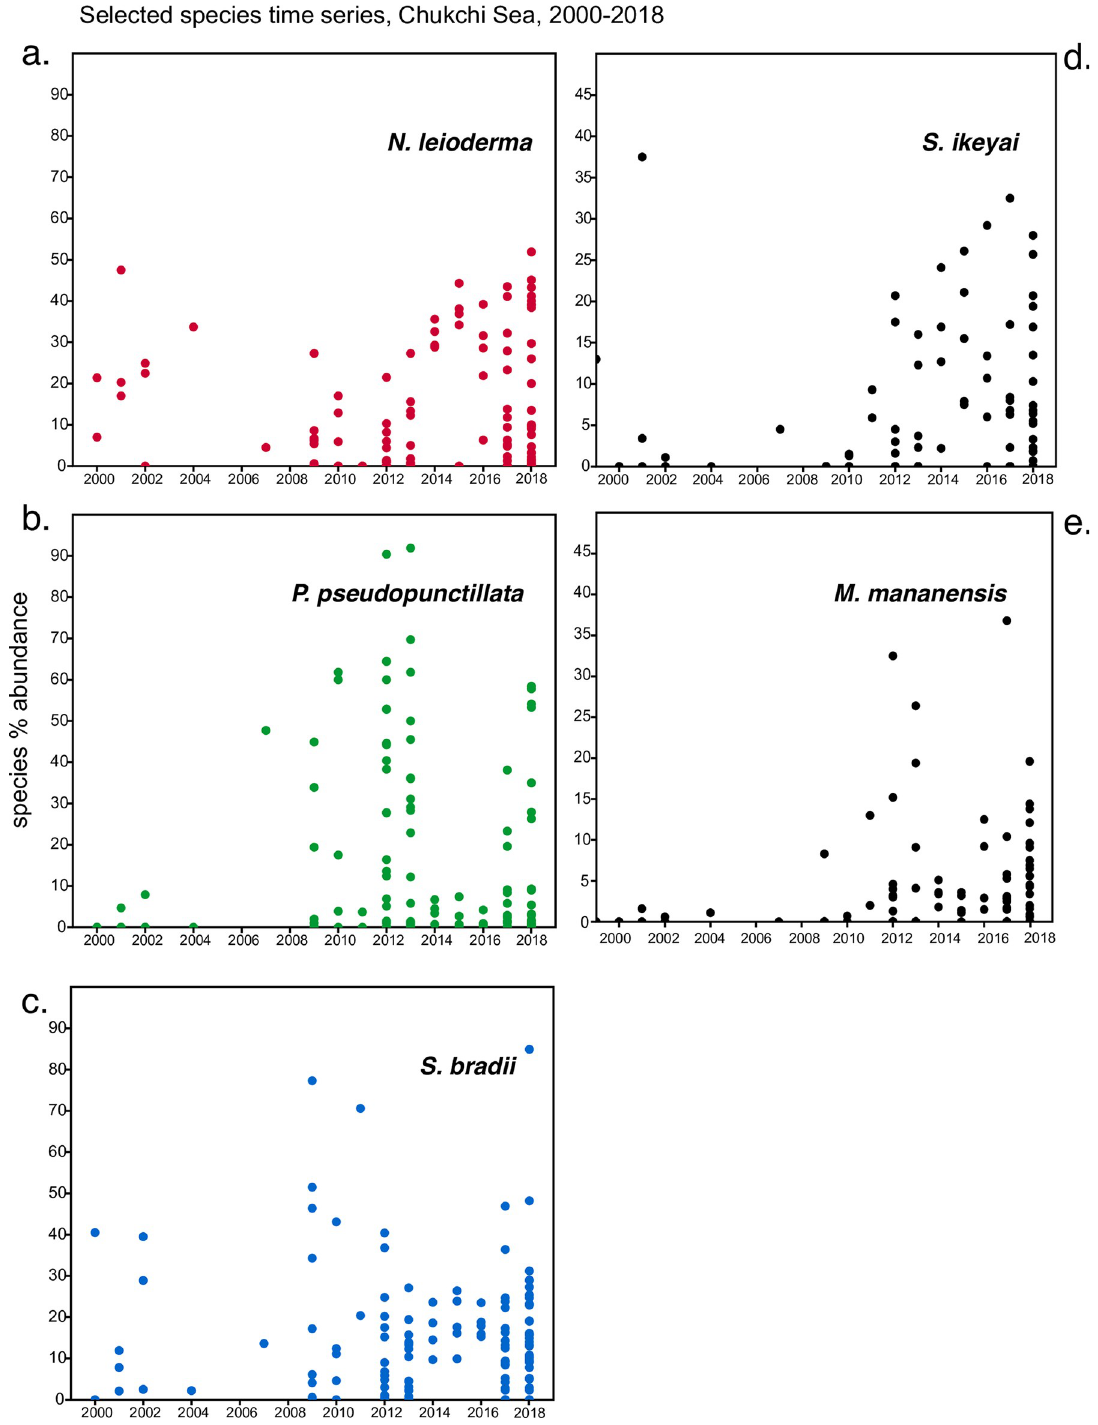
Fig 15. Time series of key species in Chukchi Sea. a.) N . leioderma , b.) P . pseudopunctillata , c.) S . bradii , d.) S . ikeyai , e.) M . mananensis